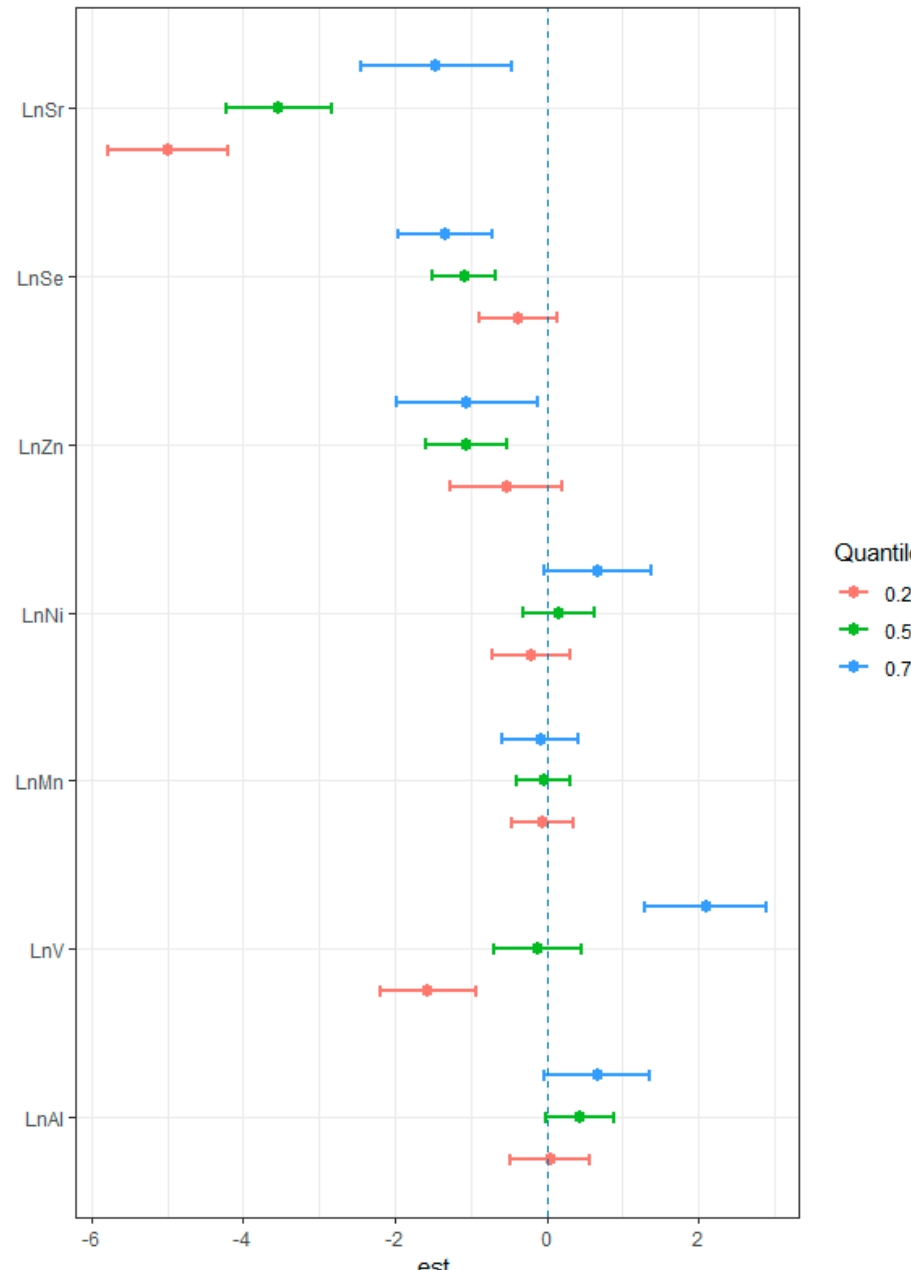
Figure 4. The individual effect of the seven elements on the risk of ESCC. Estimated values were calculated using the Bayesian kernel machine regression (BKMR) model by comparing the risk of ESCC when the other trace elements are fixed at their 25th (red), 50th (green) or 75th (blue) percentile. The model was adjusted for smoking, drinking and family history of EC.